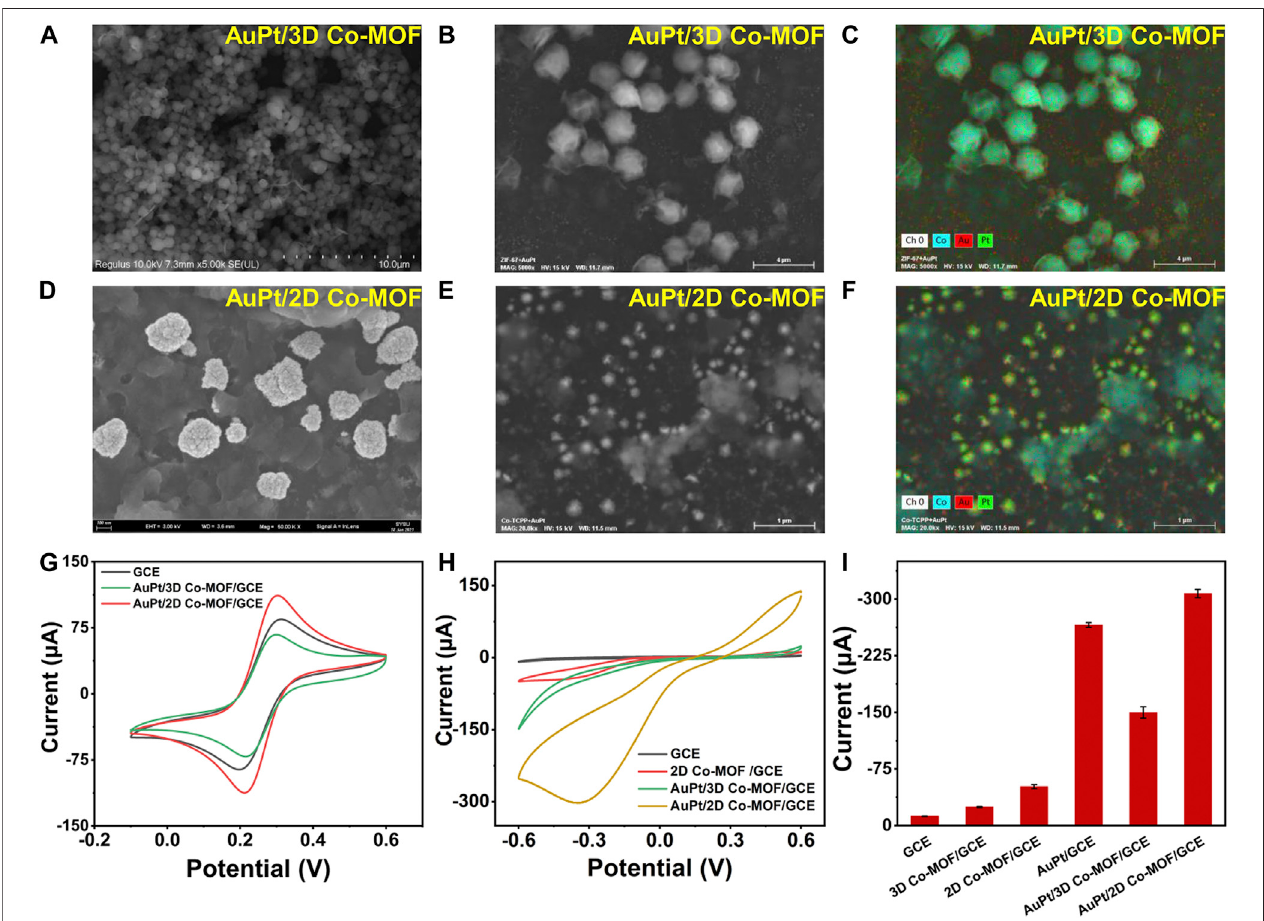
FIGURE 3 | (A,B) SEM images of 3D Co-MOF. (C) EDS mapping analysis of Au 3 Pt 7 /3D Co-MOF/GCE. (D,E) SEM images of Au 3 Pt 7 /2D Co-MOF/GCE. (F) EDS mapping analysis of